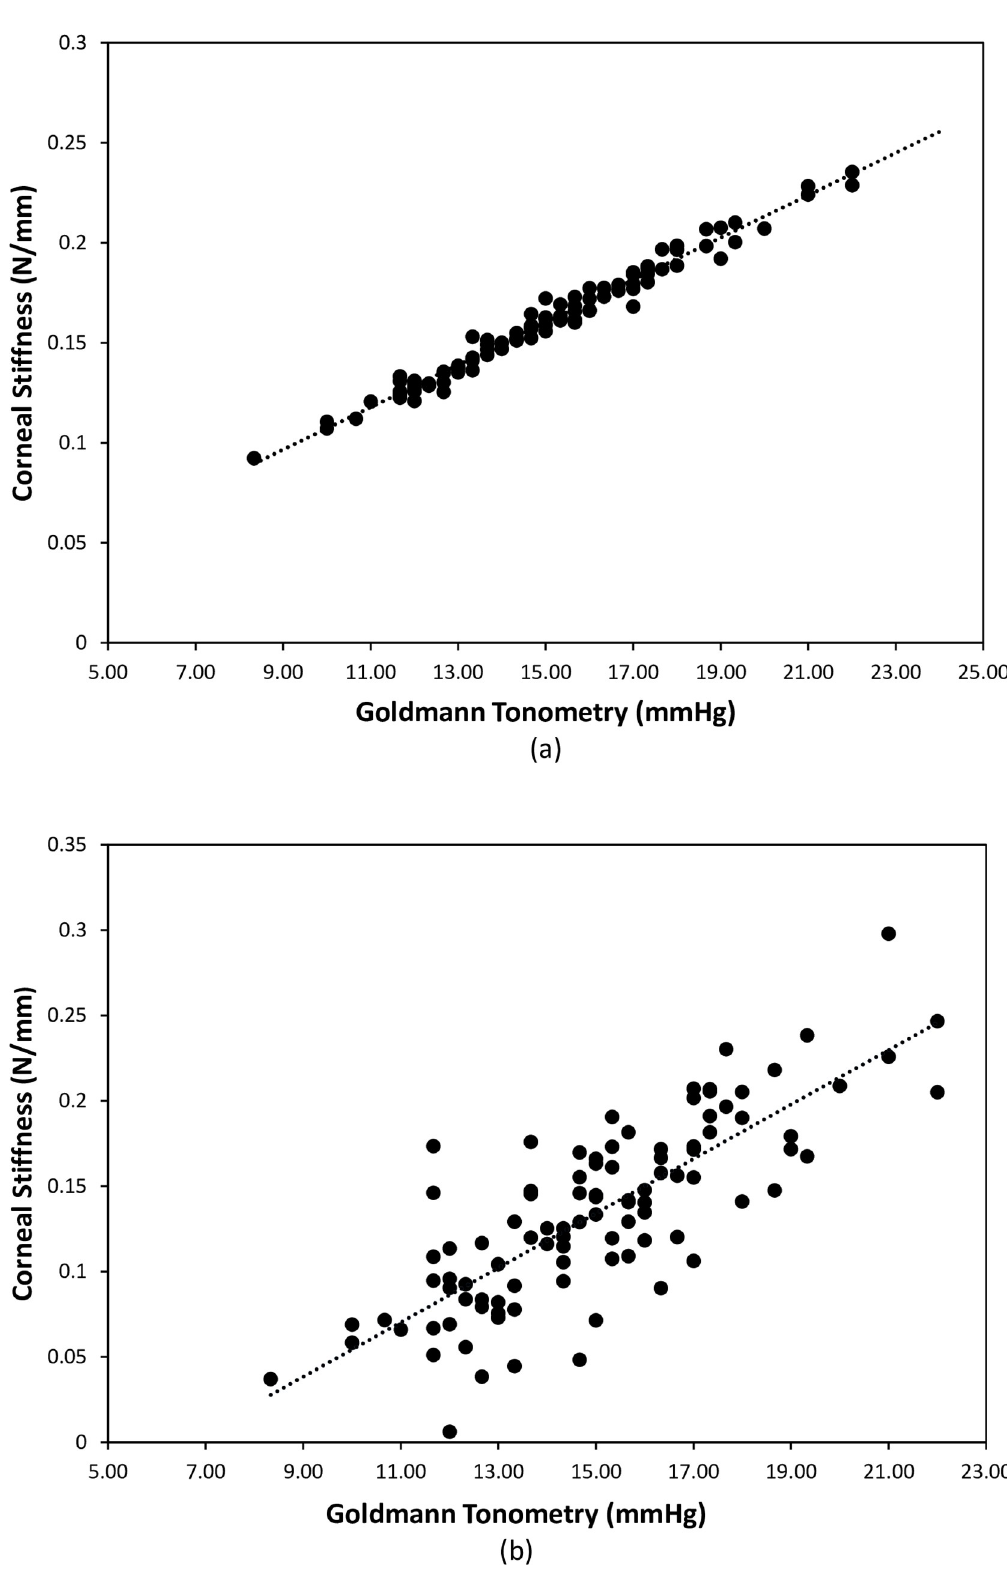
Fig 8. Correlation between corneal stiffness and IOPG calculated from (a) Eiopg (r = 0.989, p < 0.001); (b) Ecalc (r = 0.801, p < 0.001). https://doi.org/10.1371/journal.pone.0224824.g008 PLOS ONE | https://doi.org/10.1371/journal.pone.0224824 January 8,